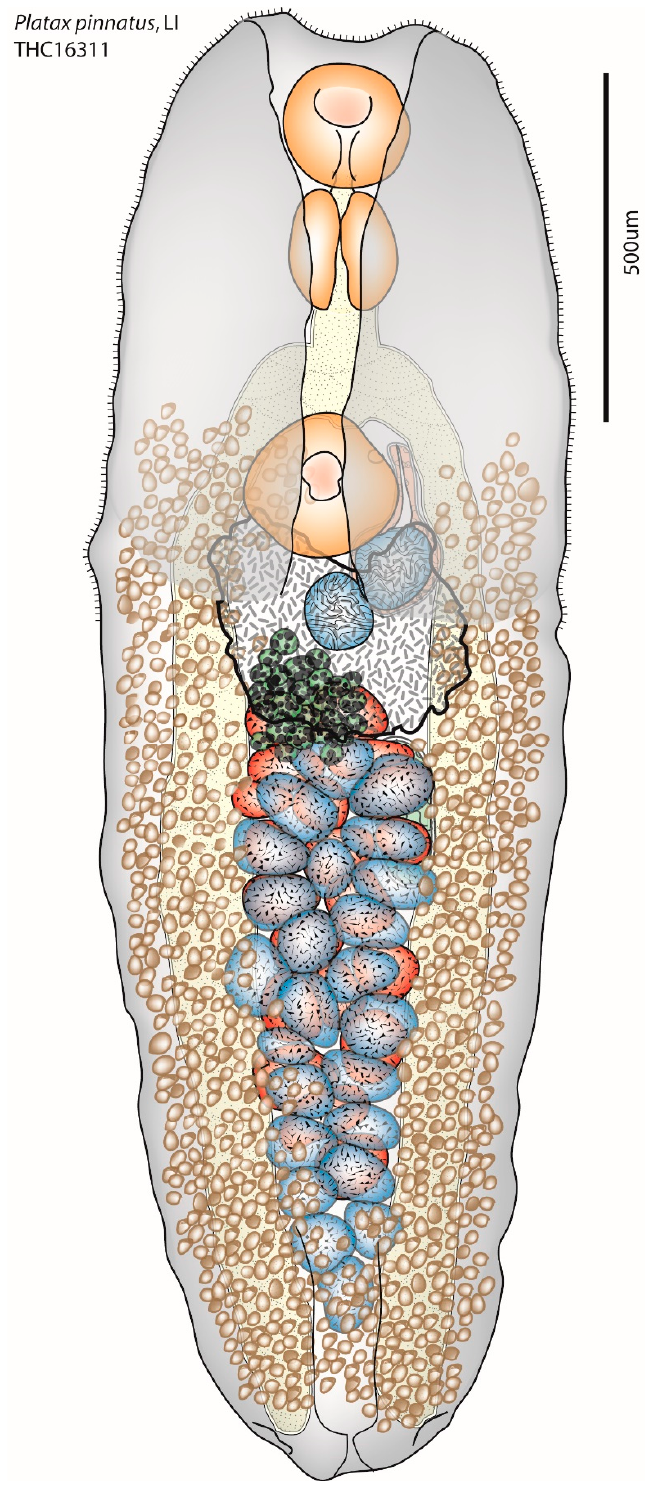
Figure 1. Deraiotrema platacis Machida, 1982. Ventral view, testes in ventral field blue, dorsal field red. Scale bar 500 μ m.